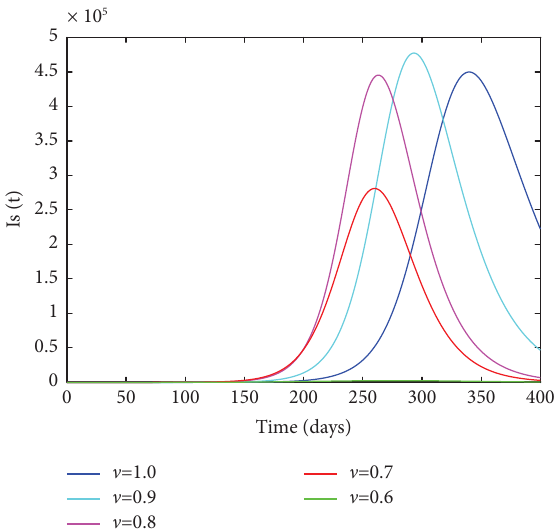
Figure 5: Behaviour of the symptomatic individuals at diferent values of v